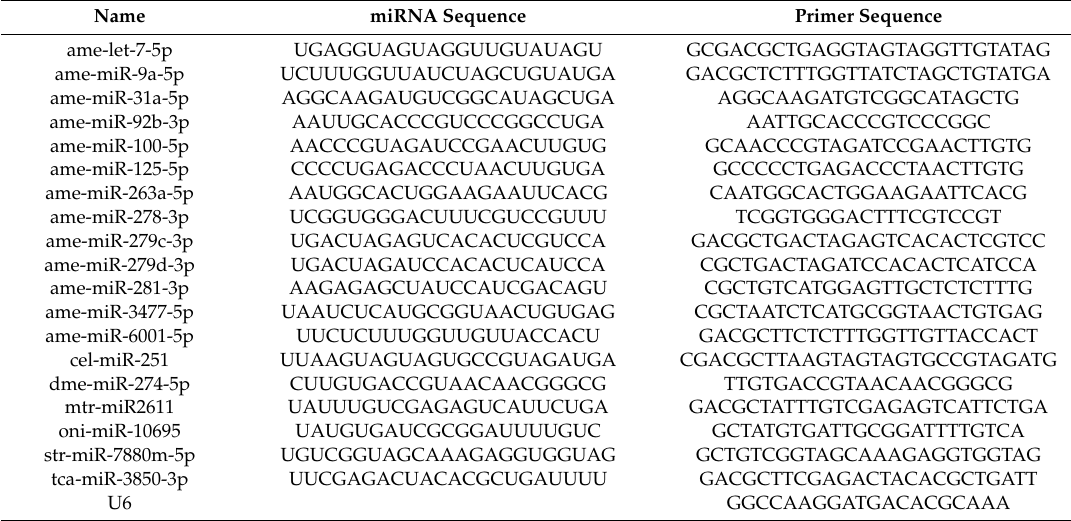
Table 1. Forward primers used for the reverse transcription quantitative PCR (RT-qPCR) analysis of the three castes of B. lantschouensis